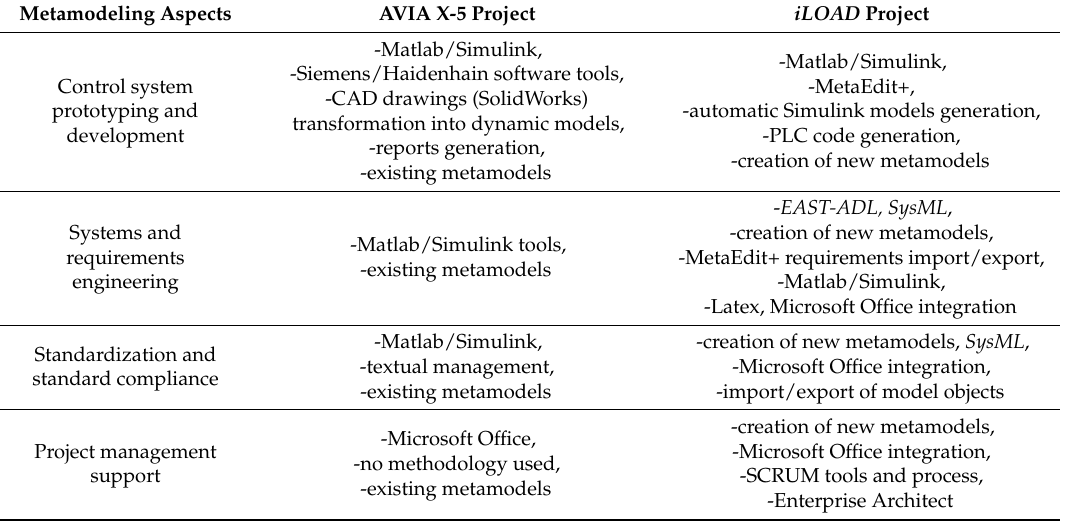
Table 2. Metamodeling